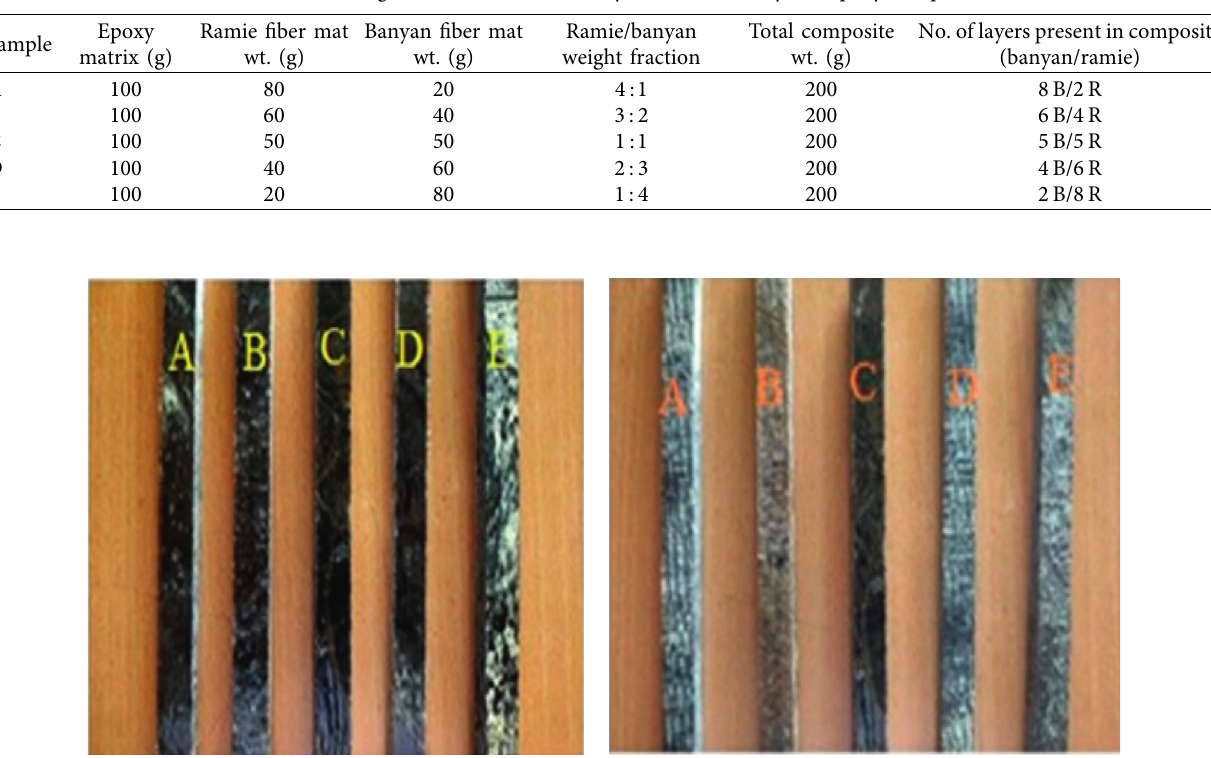
Table 2: The weight concentrations of banyan/ramie fiber hybrid epoxy composite.